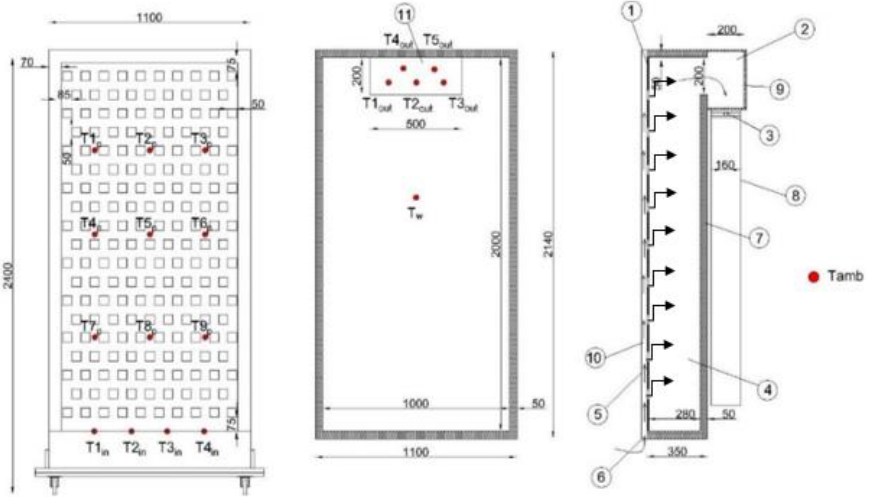
Figure 1. GTC design details: 1 — transpired steel plate; 2 — plenum; 3 — fan; 4 — inner cavity; 5 — glaz- ing; 6 — air inlet; 7,9 — thermal insulation; 8 — air duct; 10 — air layer between glass and absorber; 11 — air outlet.